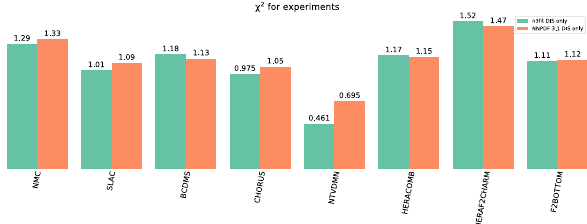
Fig. 5 Comparison of the χ 2 experiment by experiment between the new and old codes. An experiment is comprised of one or more datasets of experimental data. All datasets in this plot correspond to DIS-type experiments